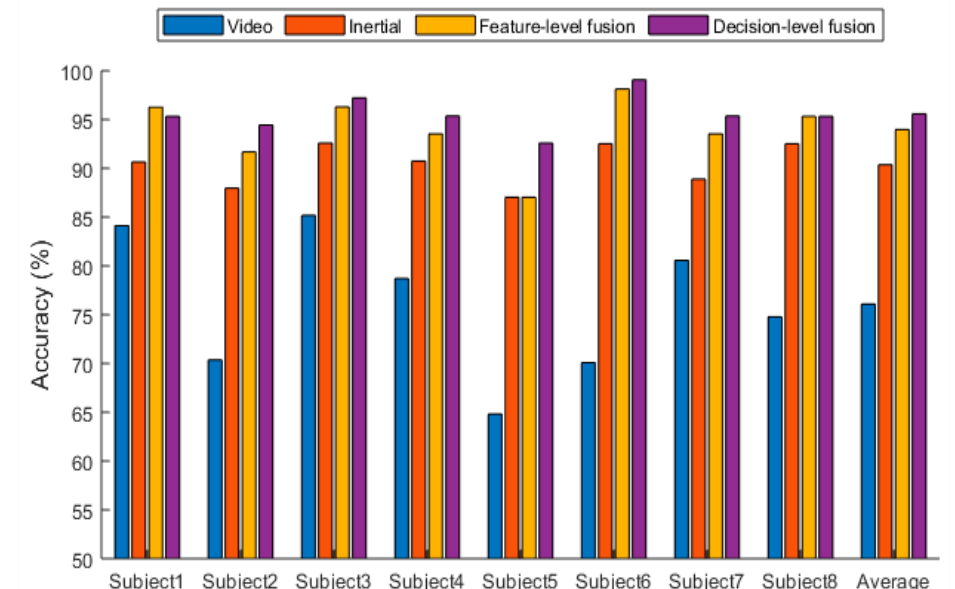
Figure 5. Recognition accuracy for the four situations of sensing modality across the eight subjects in UTD-MHAD dataset.